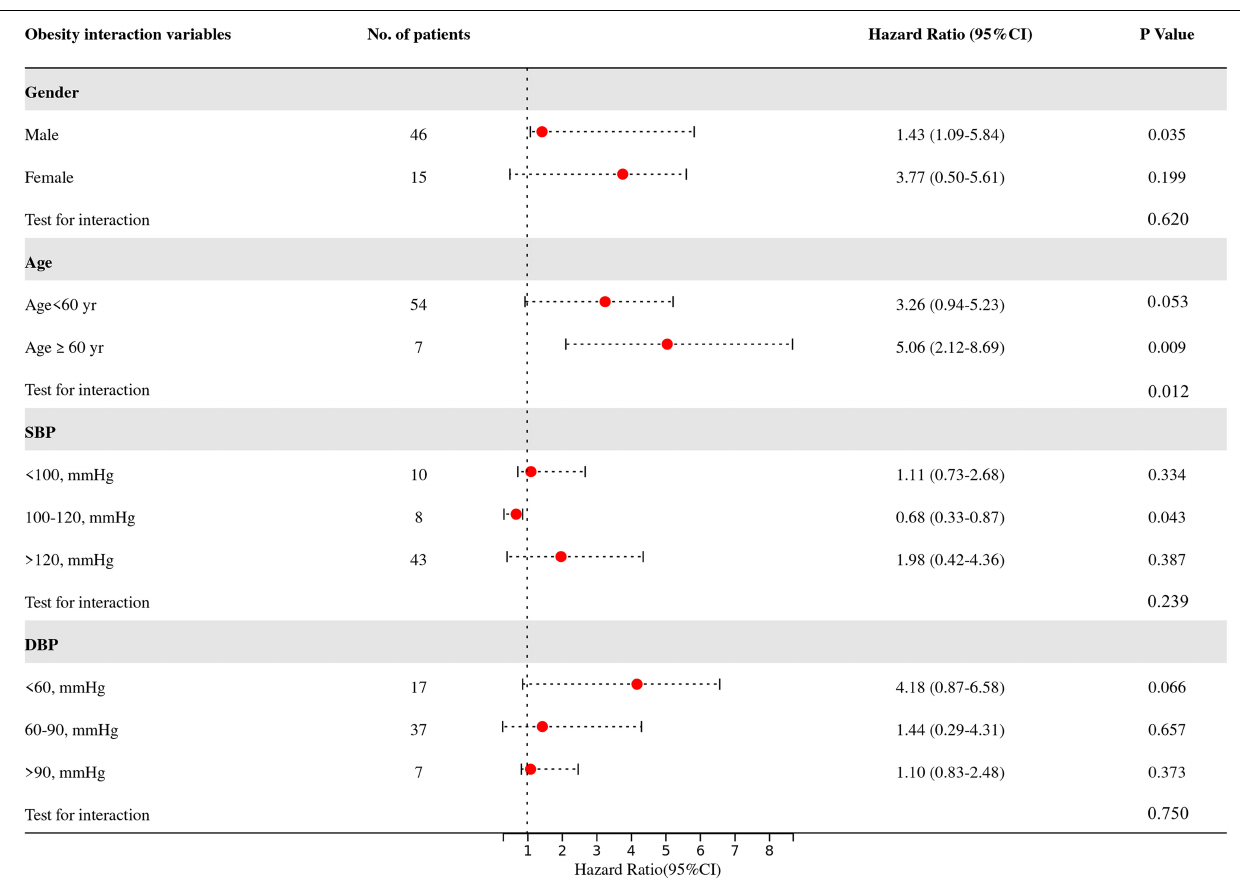
FIGURE 4 | Multivariate-adjusted hazard ratios for death in patients in the obese group as compared with the non-obese group, according to four prognostic factors. Adjust variables: gender, age, SBP, DBP, heart rate, pre-operative delirium, LEVF 20–40%, time of ventricular fibrillation during surgery, aortic valve replacement, CABG, post-operative PLR, post-operative NLR, renal replacement therapy, and stroke. SBP, systolic blood pressure; DBP, diastolic blood pressure; LEVF, left ventricular ejection fraction; CABG, coronary artery bypass graft; PLR, platelet lymphocyte ratio; NLR, neutrocyte lymphocyte